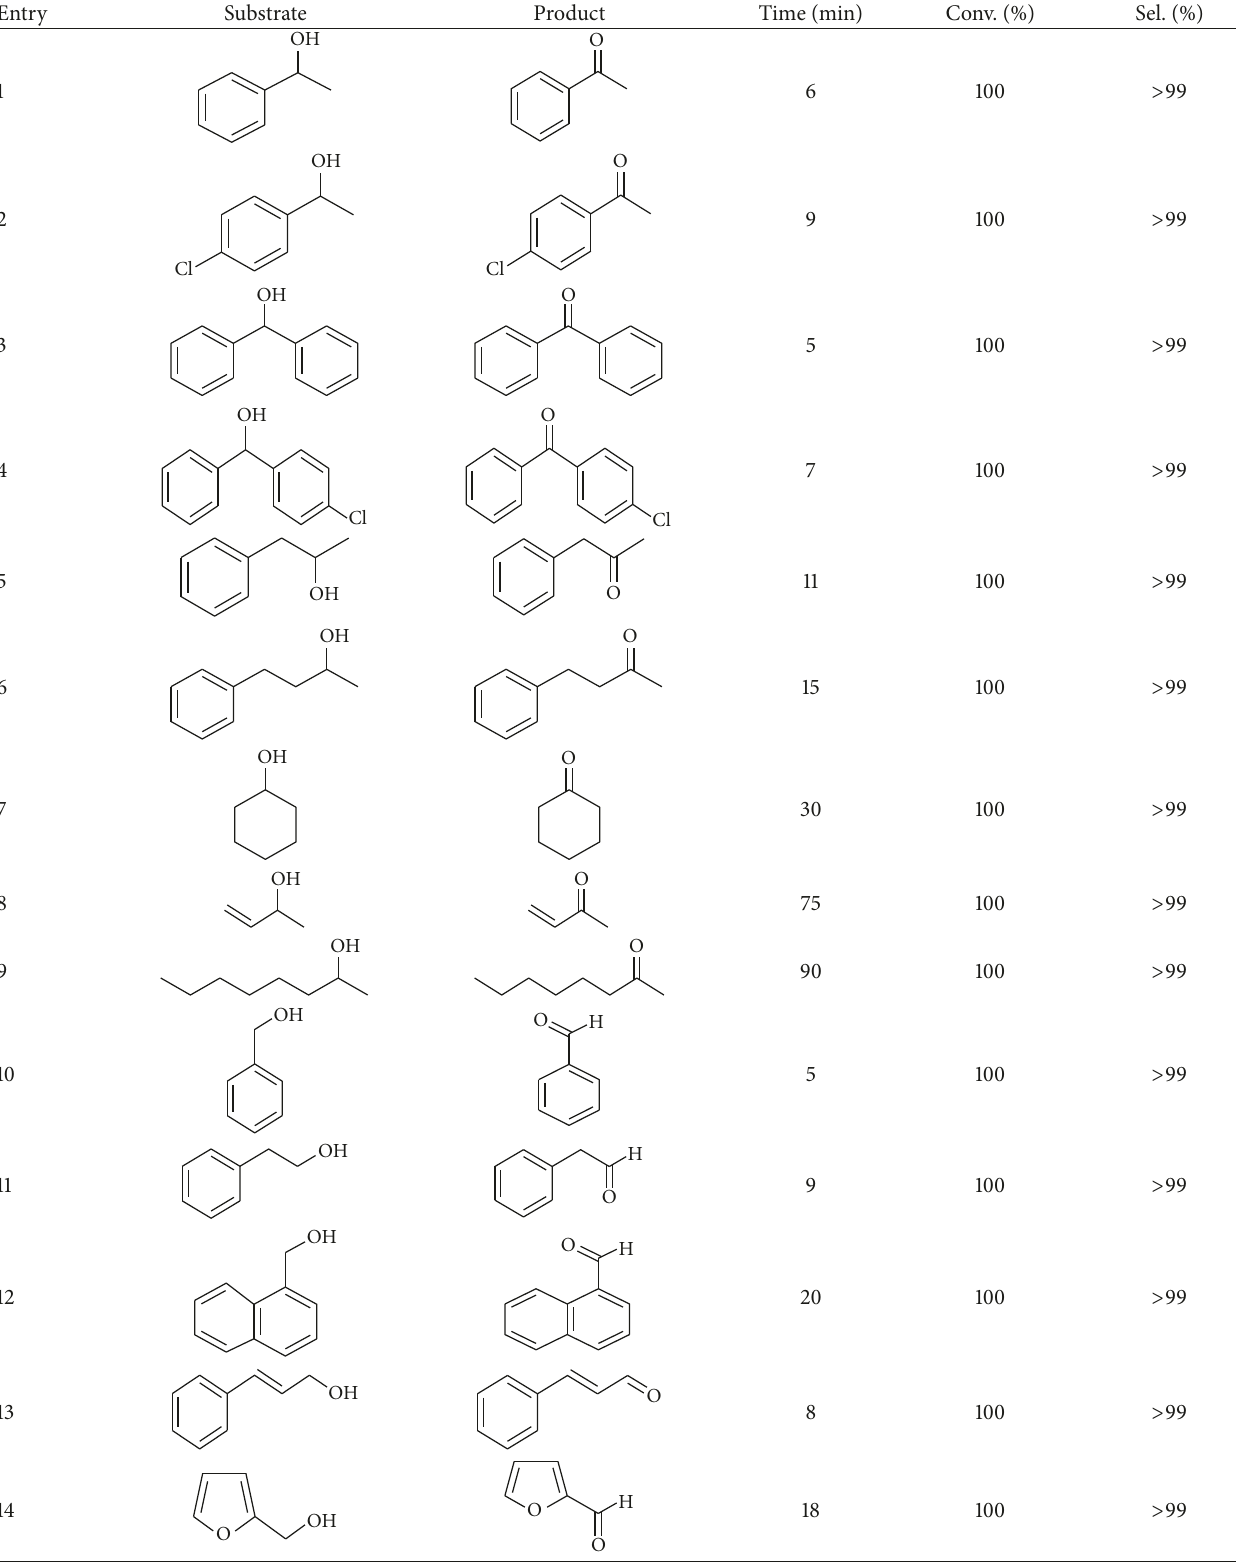
Table 6: Oxidation of a variety of alcohols catalyzed by 1% ZrO